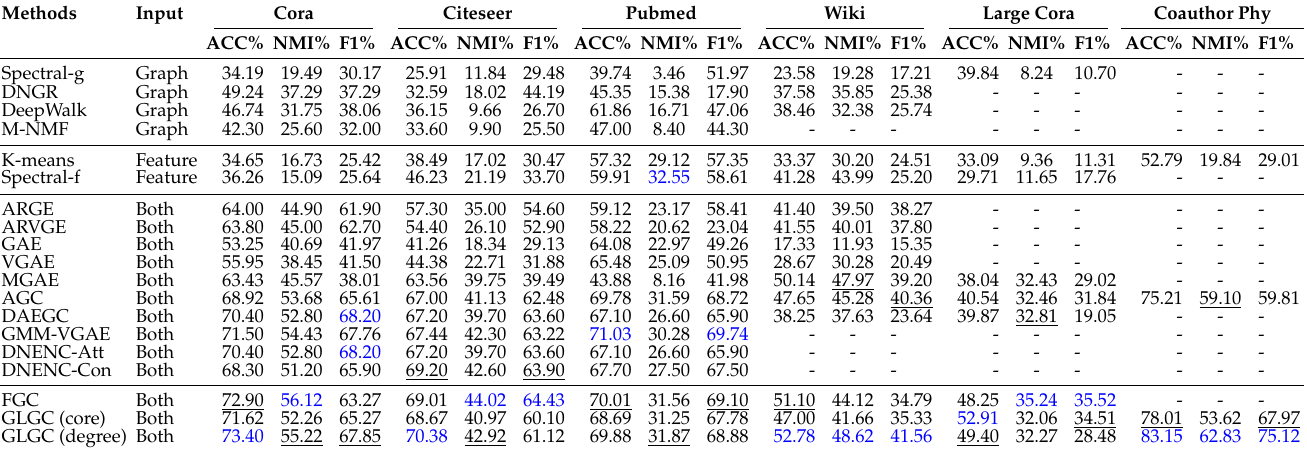
Table 2. Clustering performance on all datasets. The top and second-best outcomes are marked in blue and are underlined,